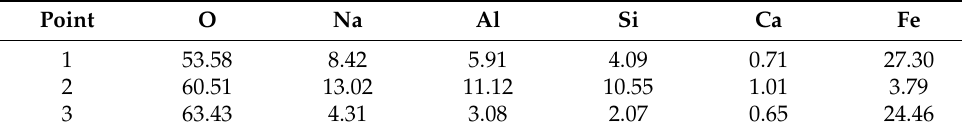
Figure 3. SEM image of red mud ( a ) and X-ray energy spectrum analysis of red mud ( b ) in the different points(1–3). Table 2. EDS results of raw red mud corresponding to Figure 3b (in %).